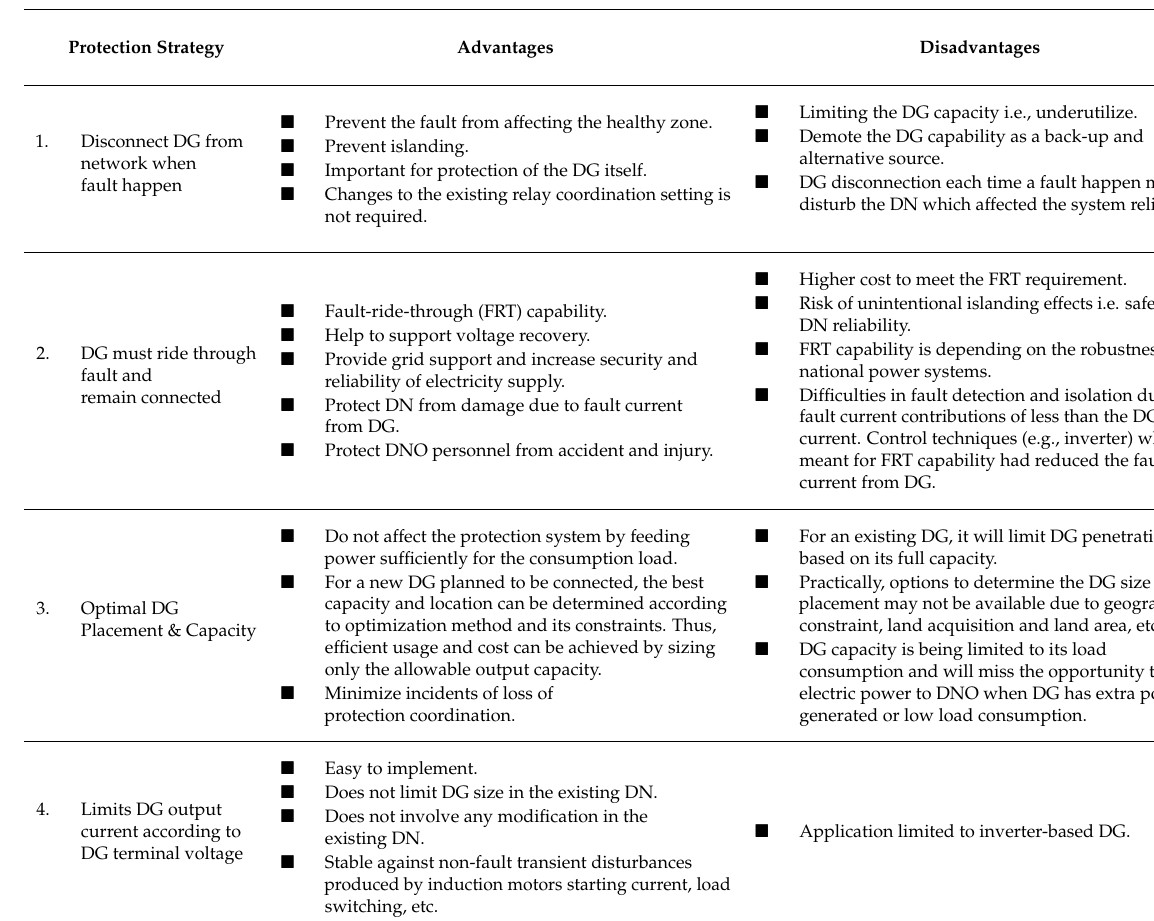
Table 1. Comparison of protection strategies for conventional DN connected with